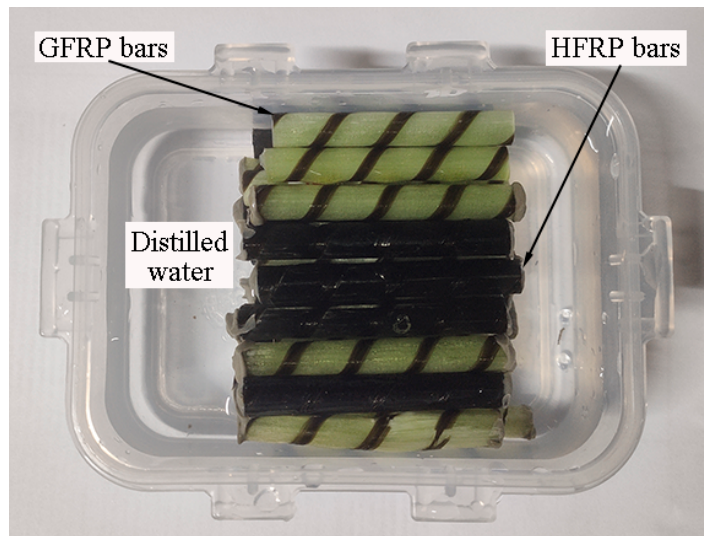
Figure 2. FRP bars immersed in the distilled water.